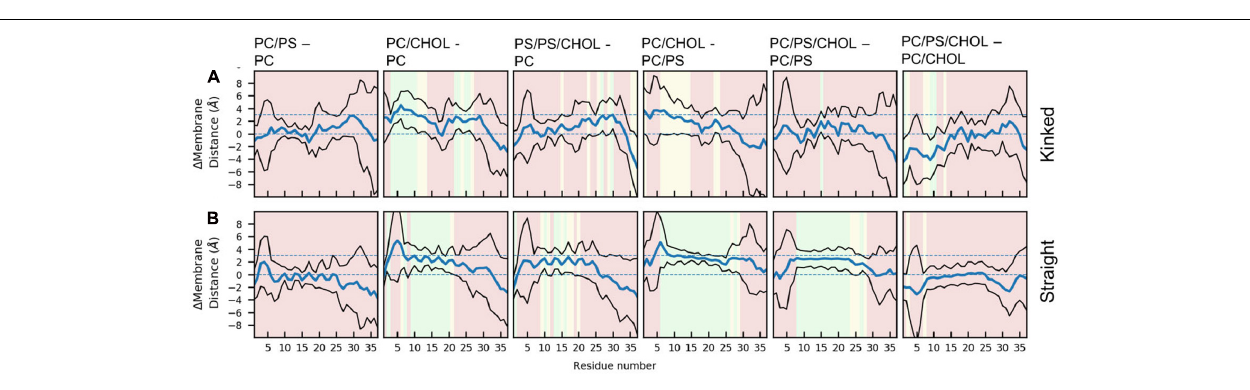
FIGURE 6 | Each panel shows the differences between the peptide insertion in the (A) kinked and the (B) straight IAPP. The mean and standard deviation is indicated with a blue and black lines, respectively. The background color of the plots indicates the significance of the difference (green: p ≤ 0.05, yellow: 0.05 < p < 0.10, red: p >